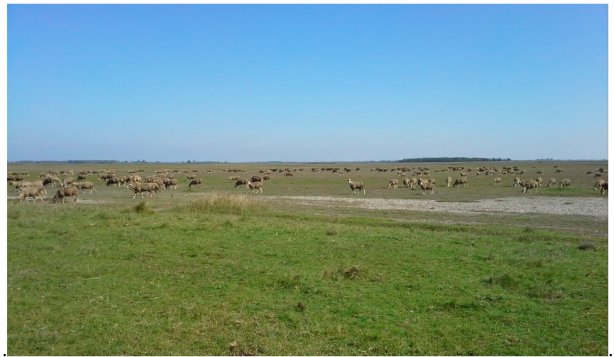
Figure 2. Early autumn view of the salt-affected landscape with grazing sheep at “Apajpuszta” near Apaj village,